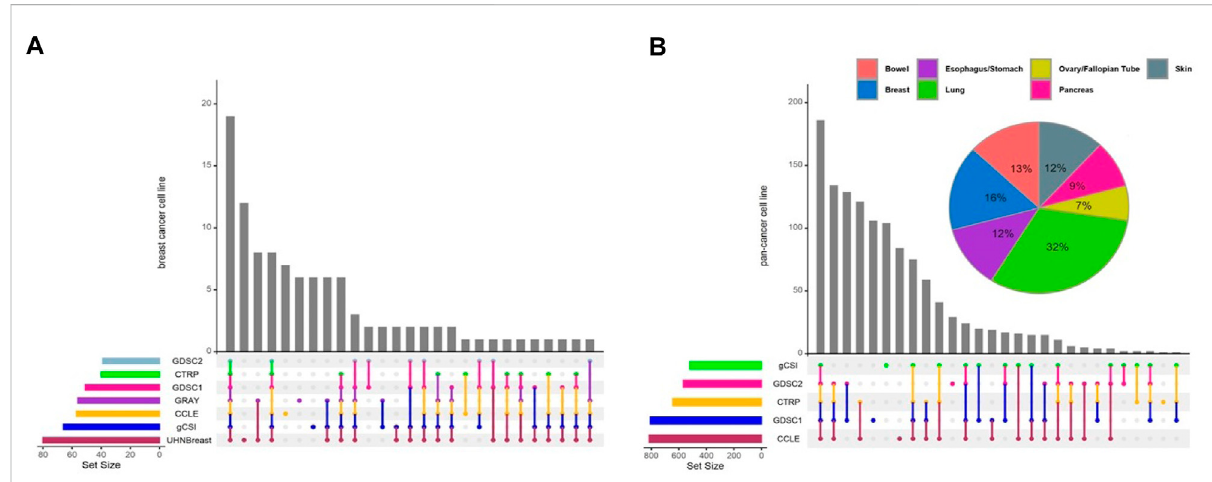
FIGURE 1 Distributionofcelllinesacrosspharmacogenomicstudies. Upsetdiagramsillustratethenumberofcelllinesforeachstudyfor (A) breastcancer and (B) pan-cancer data. Pie chart shows the distribution of common cell lines across tissue types using pan-cancer data. Tissue types contain at least 10 cell lines with available expression and drug response data included in pan-cancer